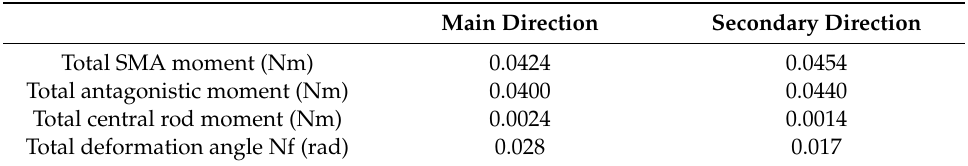
Table 2. Model results.